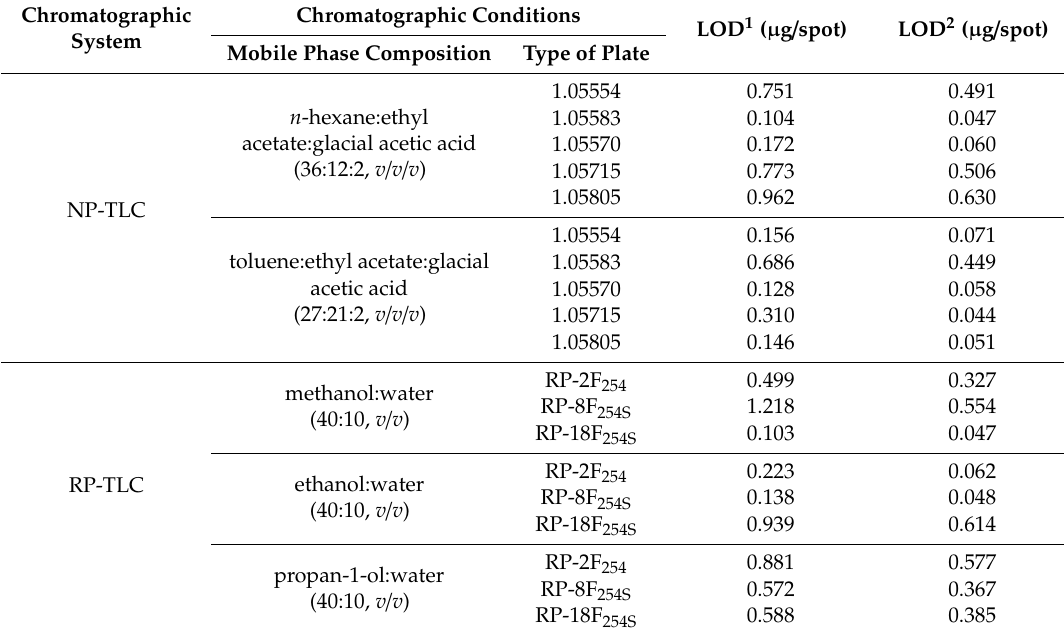
Table 3. Limit of detection (LOD) of ibuprofen determined under di ff erent conditions in NP-TLC and RP-TLC